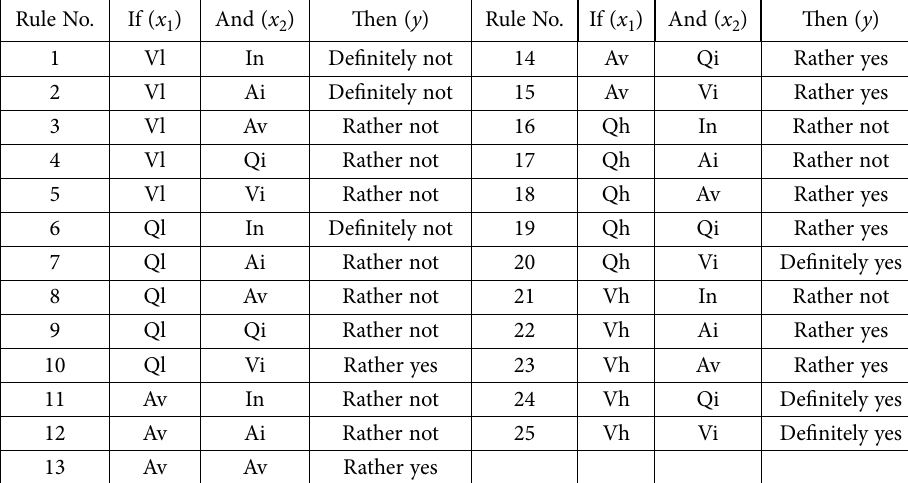
Table 4. Rules for the inferential block